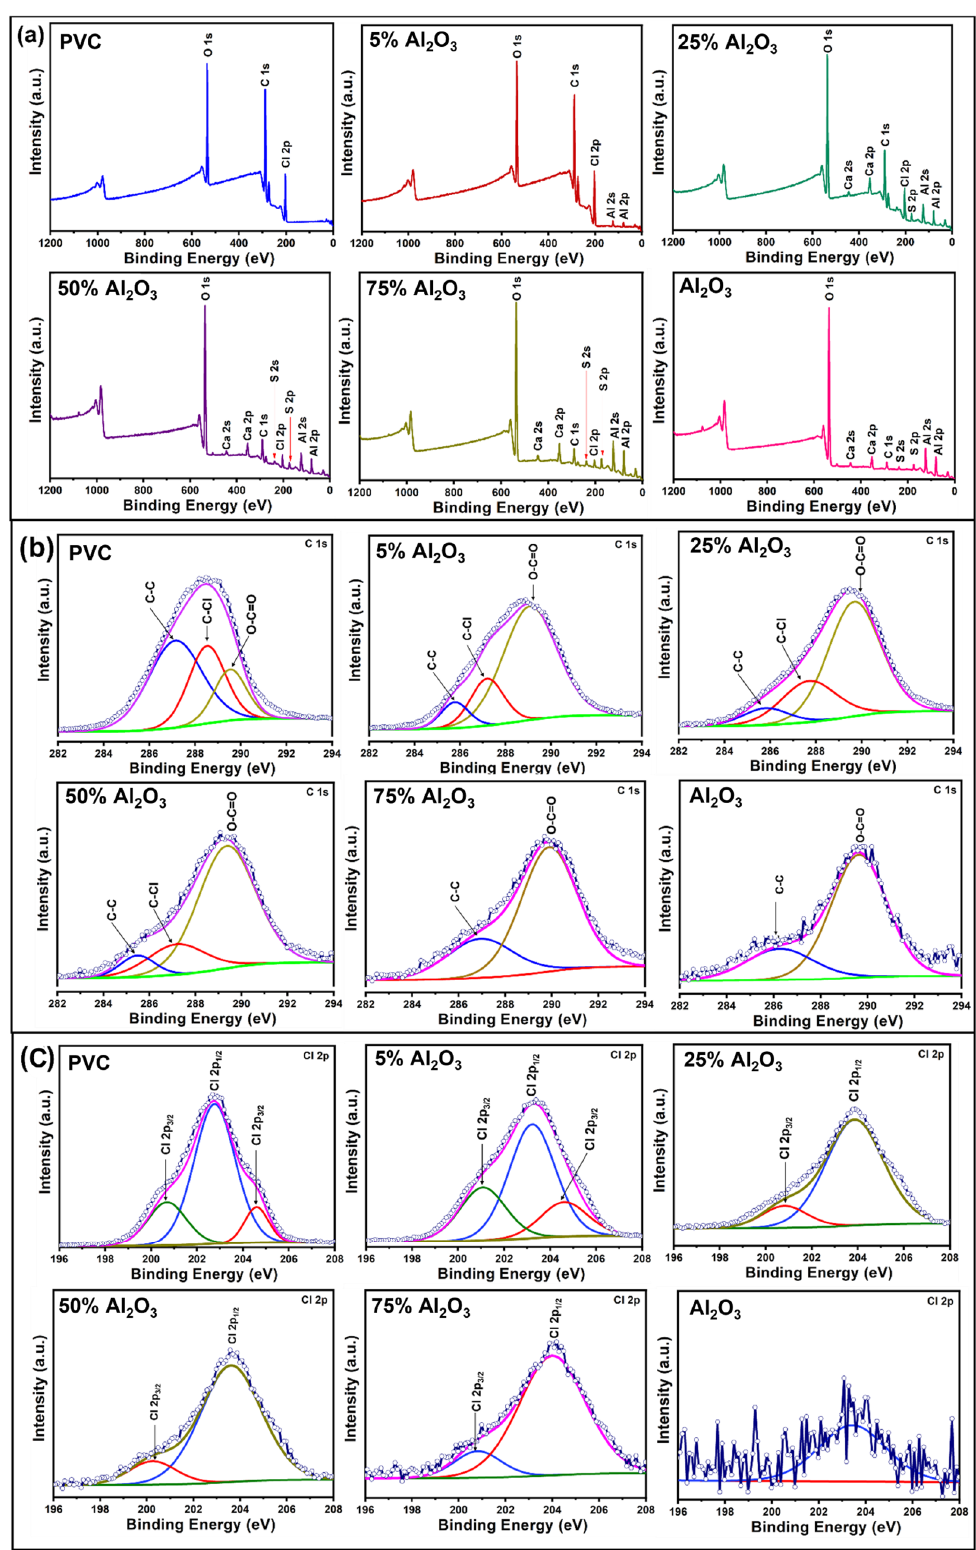
Figure 6. XPS survey ( a ), C 1 s ( b ), and Cl 2 p ( c ) spectra of Al 2 O 3 , PVC, and Al 2 O 3 /PVC samples containing different aluminum trioxide amounts as indicated.